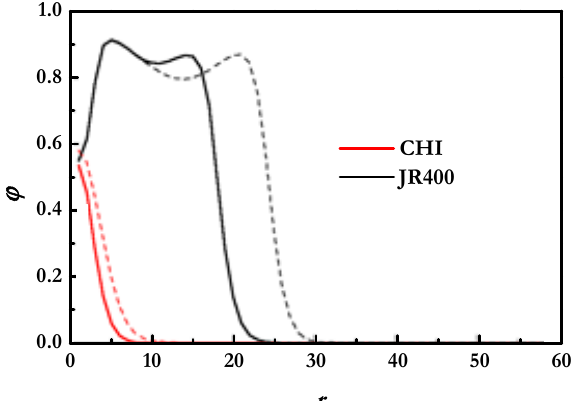
Figure 4. Polymer density profiles analyzed perpendicularly to the surface for CHI and JR400 layers deposited from solutions with a NaCl concentration of 100 mM. The profiles were obtained at two di ff erent polymer concentrations. Continuous lines correspond to the profiles of layers deposited from solutions with the lowest concentration, and dashed lines correspond to the profiles of layers deposited from solutions with the highest concentration.